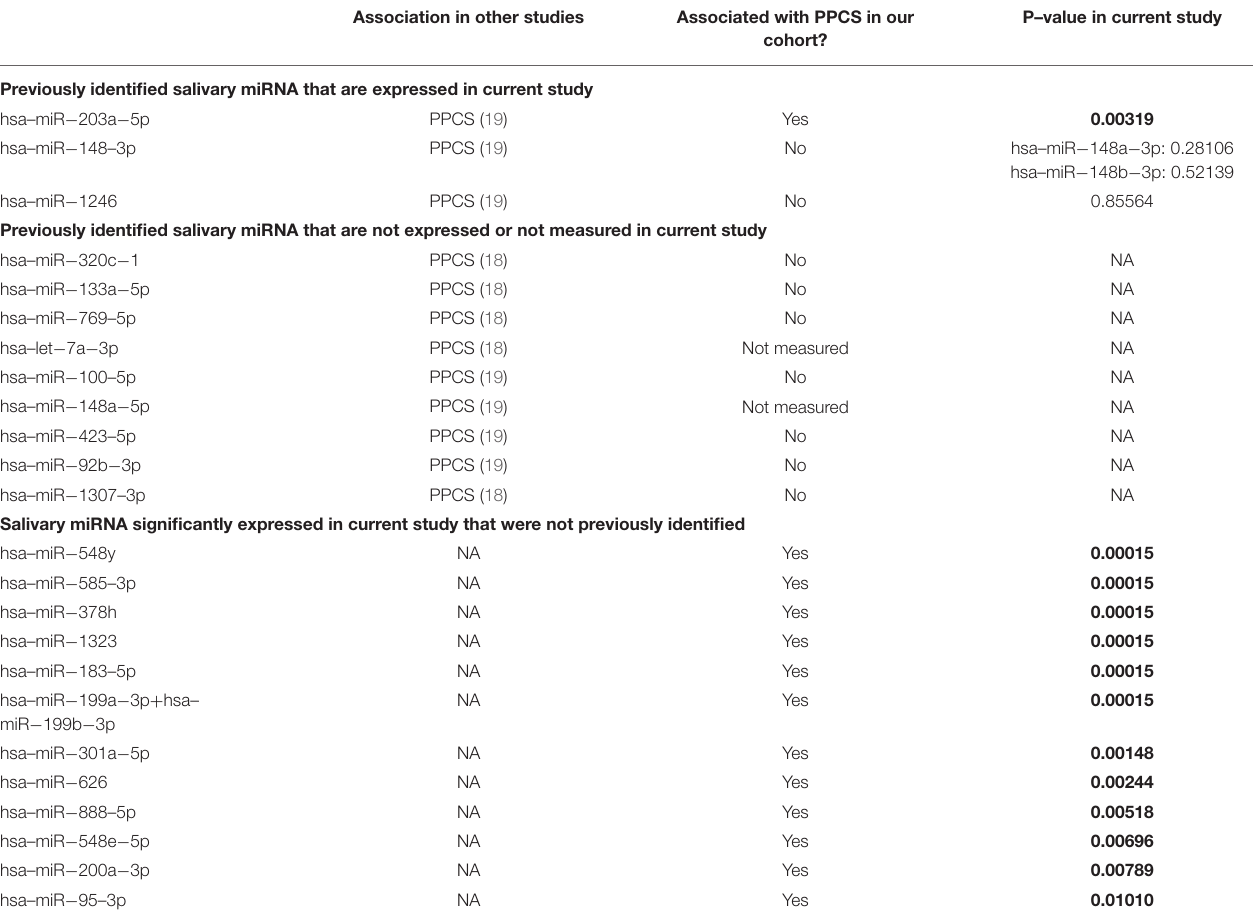
TABLE 3 | Previously identified potential salivary miRNA biomarkers associated with persistent post–concussive symptoms